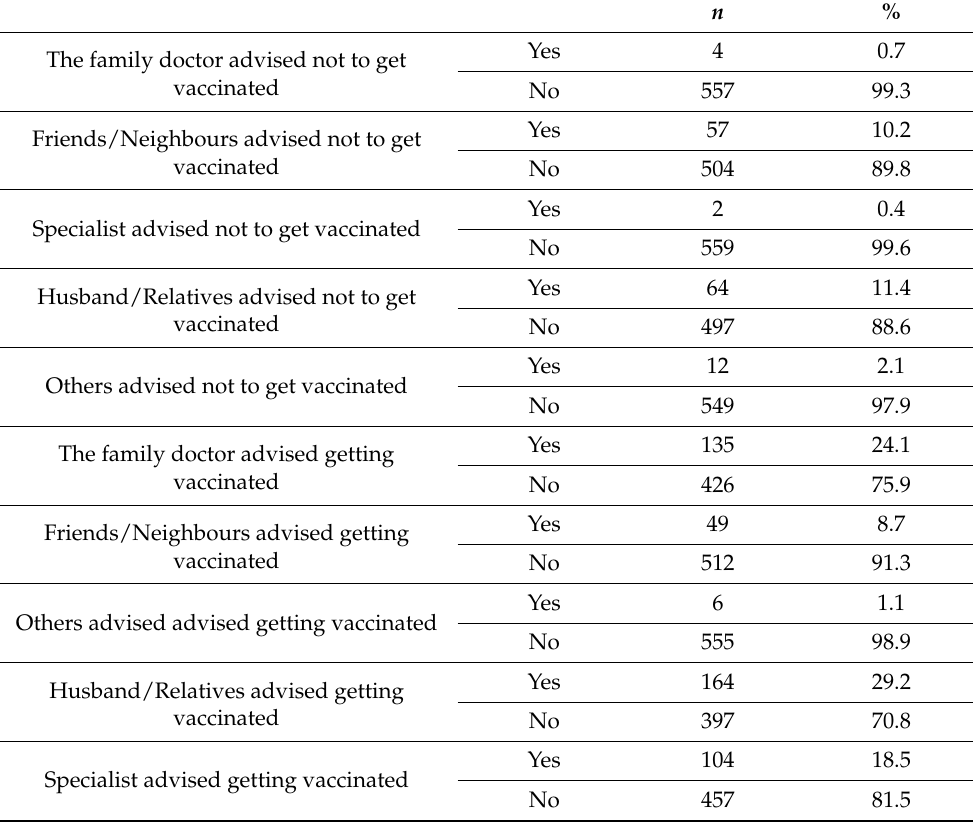
Table 2. Distribution of participants according to whether or not they received advice about get- ting vaccinated.